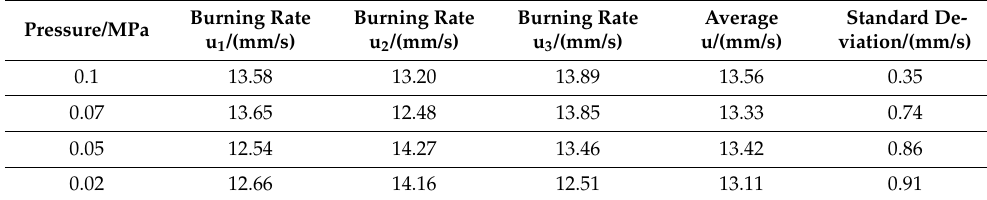
Table 5. Results of laser ignition energy of B(11%)/NC/CuO thermite. Energy (mJ) √ Note: stands for ignited, × stands for